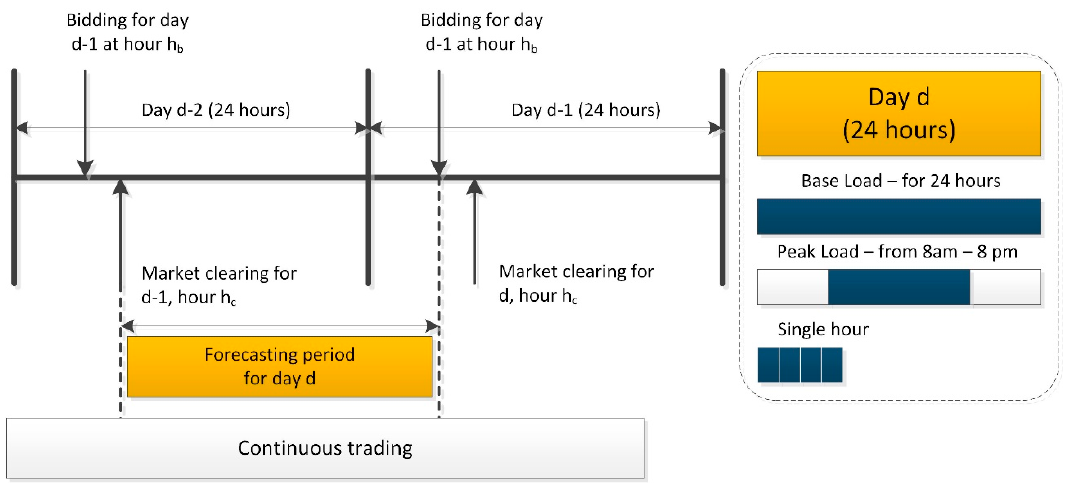
Figure 9 . Time schedule for spot and continuous trading. Figure 9. Time schedule for spot and continuous trading. Table 1. Available data set for the Hungarian power market based on data